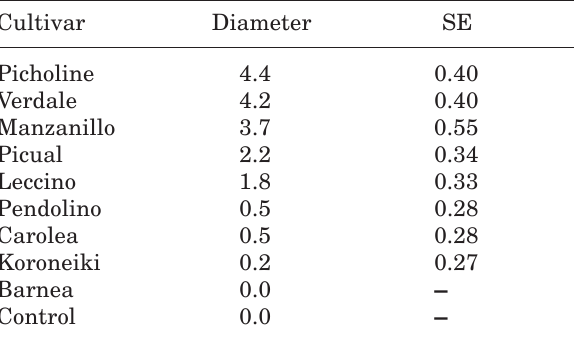
Table 5. Mean gall diameter (mm) in 9 olive cultivars inoculated with P. savastanoi olive knot strain ICMP 13519 at 3 (cid:1) 10 6 cfu ml -1 , recorded after 10 months. Mean diameters with their standard errors are